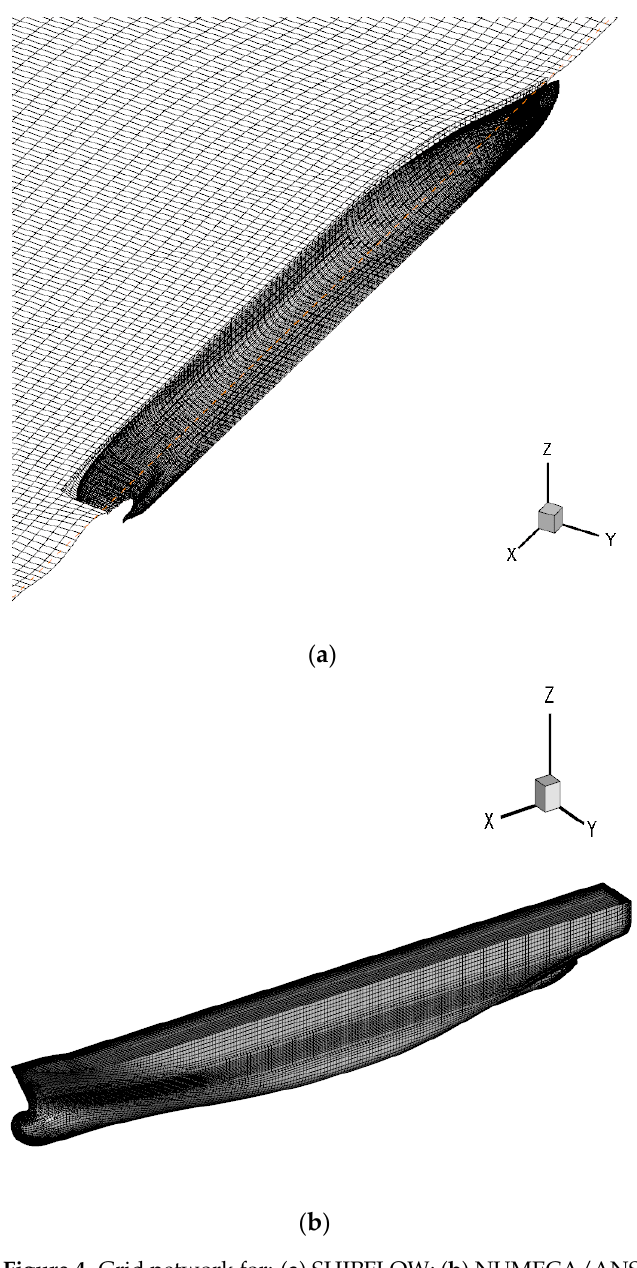
Figure 4. Grid network for: ( a ) SHIPFLOW; ( b ) NUMECA/ANSYS. The setup for time configuration was chosen for a steady flow. The RANS flow solver [19,22,23] was used for all simulations using the Volume of Fluid (VOF) method (free surface capturing approach) and the k- ω (Menter Shear-Stress Transport [30]) turbulence model. The k- ω Shear-Stress Transport (SST) turbulence model, adopted to cal-